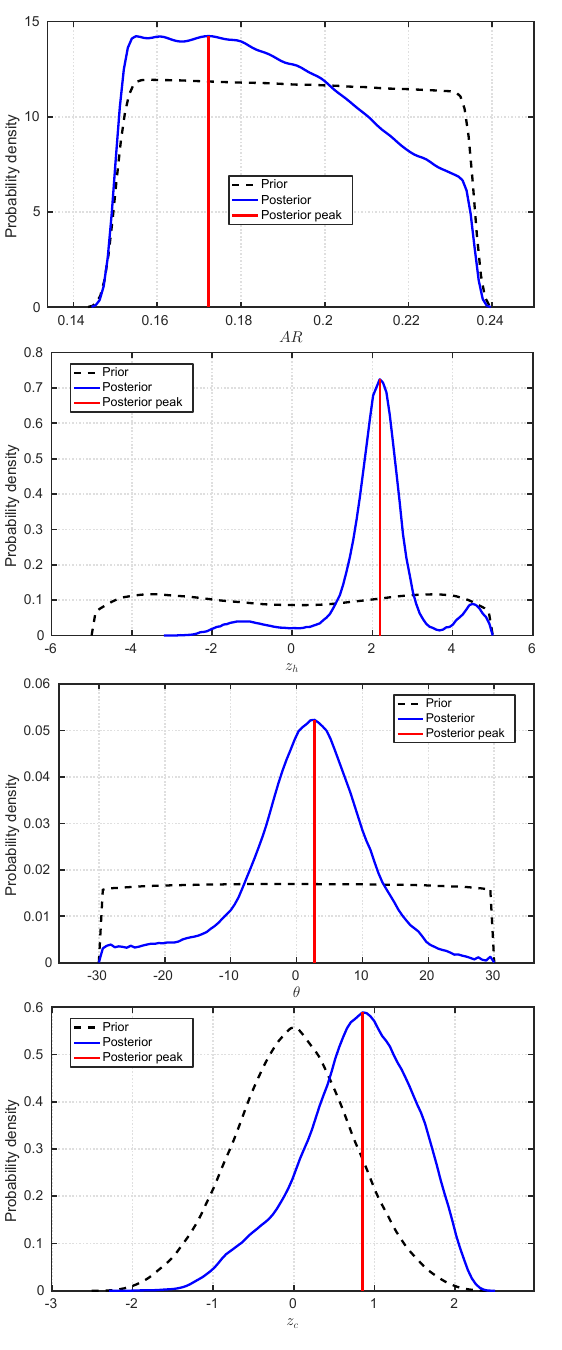
Figure 13. Prior (dashed black, derived from uniform ζ distribution in (cid:52) ) and posterior (solid blue) distributions of physical fault plane configuration parameters in restricted inference. The bottom right panel shows the inferred fault plane